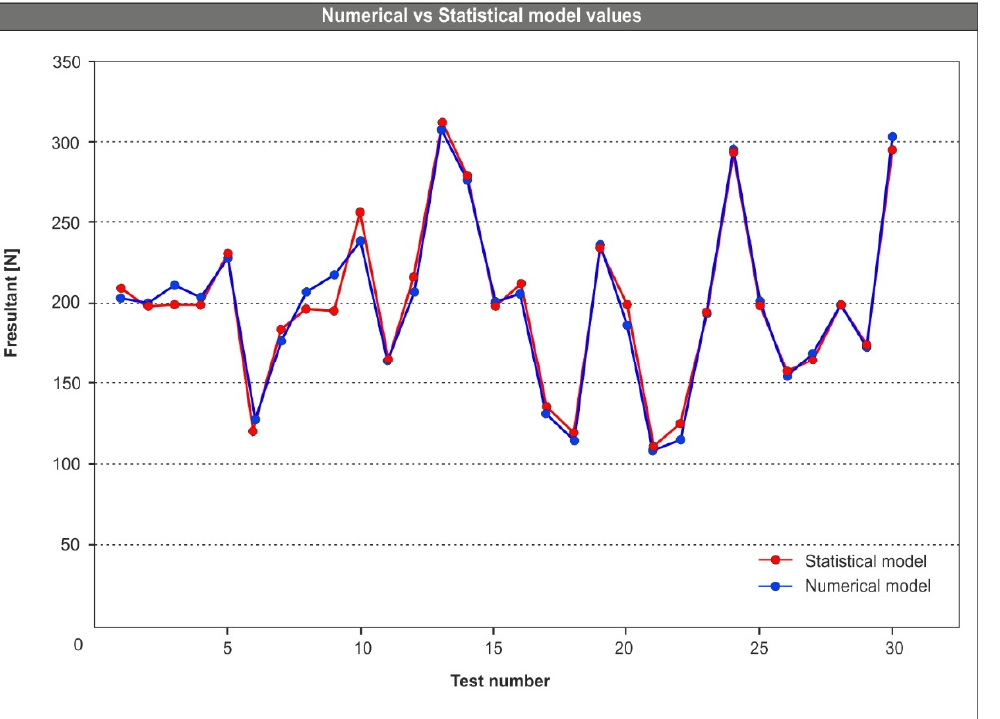
Table 5. ANOVA results for the resultant machining force based on the statistical model.